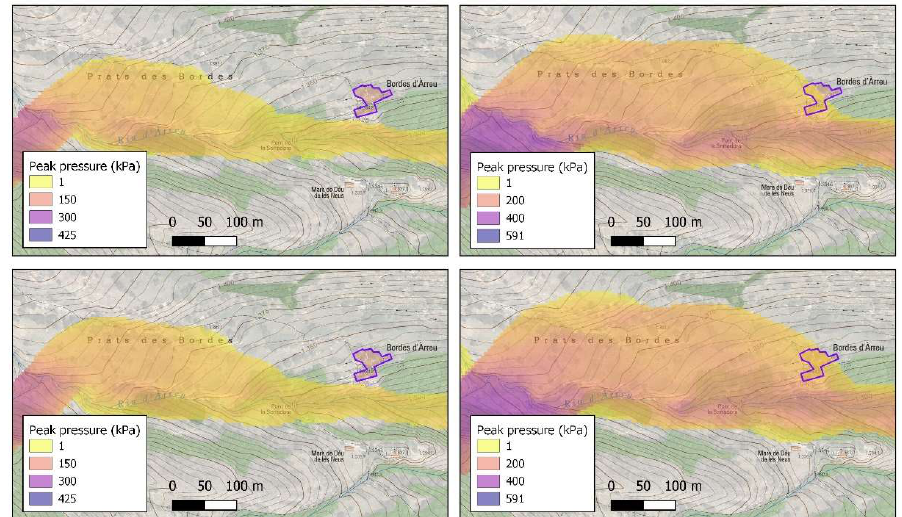
Figure 16. Detail of the DFA simulations near old Àrreu, comparing simulation runs with (lower panels) and without (upper panels) topographical changes due to the deposition of a previous avalanche event. Simulation considering a mid-frequency release area and a release snow depth corresponding to T30 (192 × 10 3 m 3 , left panels) and simulation considering a low-frequency release area and a release snow depth corresponding to T30 (603 × 10 3 m 3 , right